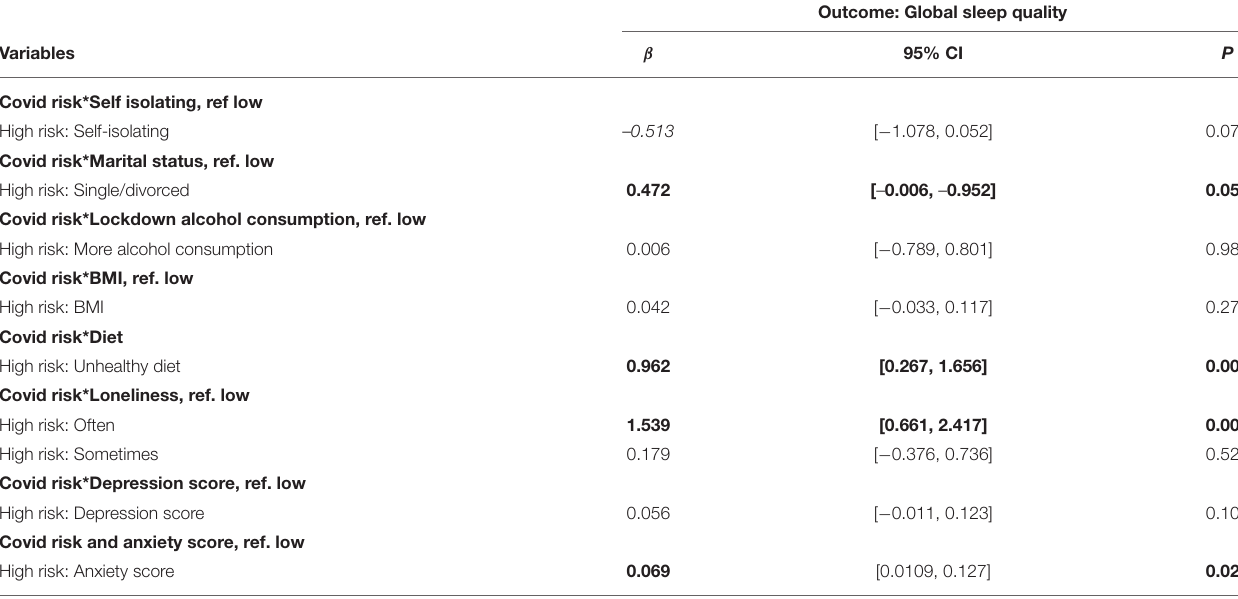
Outcome: Global sleep quality